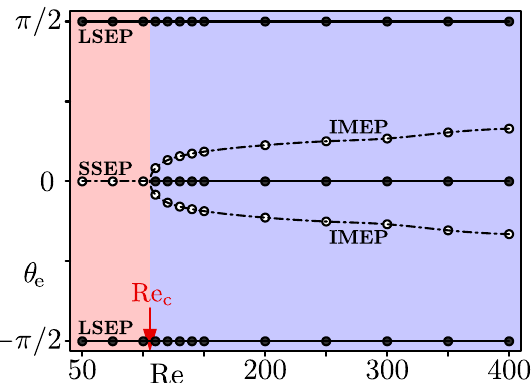
Figure 5. The diagram for the azimuthal angle θ e of particle equilibrium points. θ e = 0: short side equilibrium point (SSEP). − π /2 < θ e < 0, 0 < θ e < π /2: intermediate equilibrium point (IMEP). θ e = − π /2, π /2: long side equilibrium point (LSEP). The equilibrium points determined from the lift maps are drawn by circles. The filled circles and solid lines represent stable equilibrium points, and the open circles and dash-dotted lines correspond to saddle nodes. The particles focus on the LSEP for Re < Re c (red region), and they focus on the LSEP and SSEP for Re c < Re (blue region). A = 2, d / h =